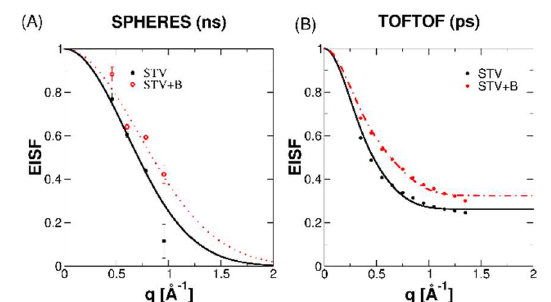
Fig. 4. EISF curves for STV and STV+B on the ns (A), and ps (B) timescale. It can be observed that free STV is more flexible than the STV+B complex [10]. Reprinted with permission from